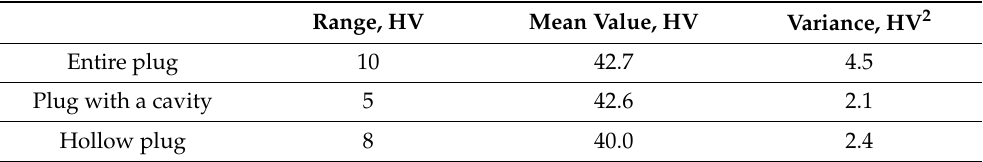
Table 2. The hardness distribution indexes in the longitudinal section of the hollow shells. Range, HV